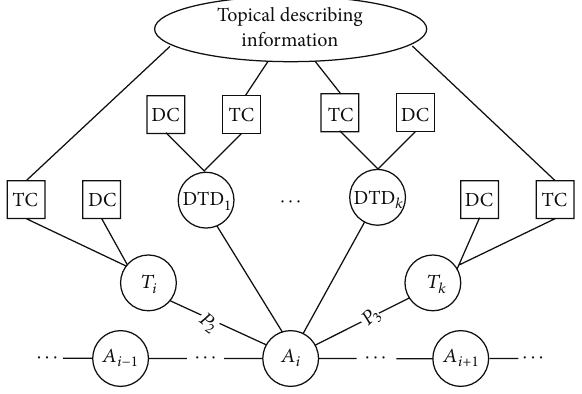
Figure 1: The topical-semantic association graph.